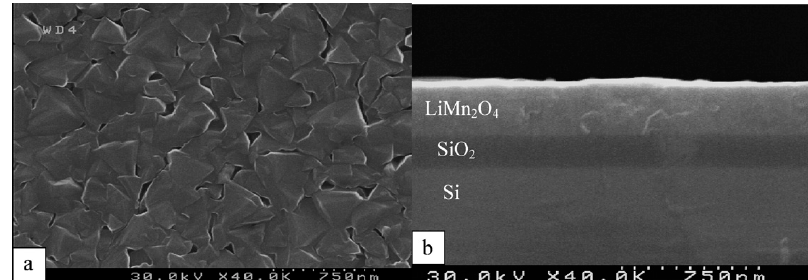
Figure 9. ( a ) Surface morphology and ( b ) cross-sectional picture of PLD-grown LMO thin film deposited on an Si(001) substrate covered by a 0.2 µm SiO 2 layer at 575 °C under a 13 Pa oxygen partial pressure. (Reproduced with permission from [135]. Copyright 2008 Elsevier).